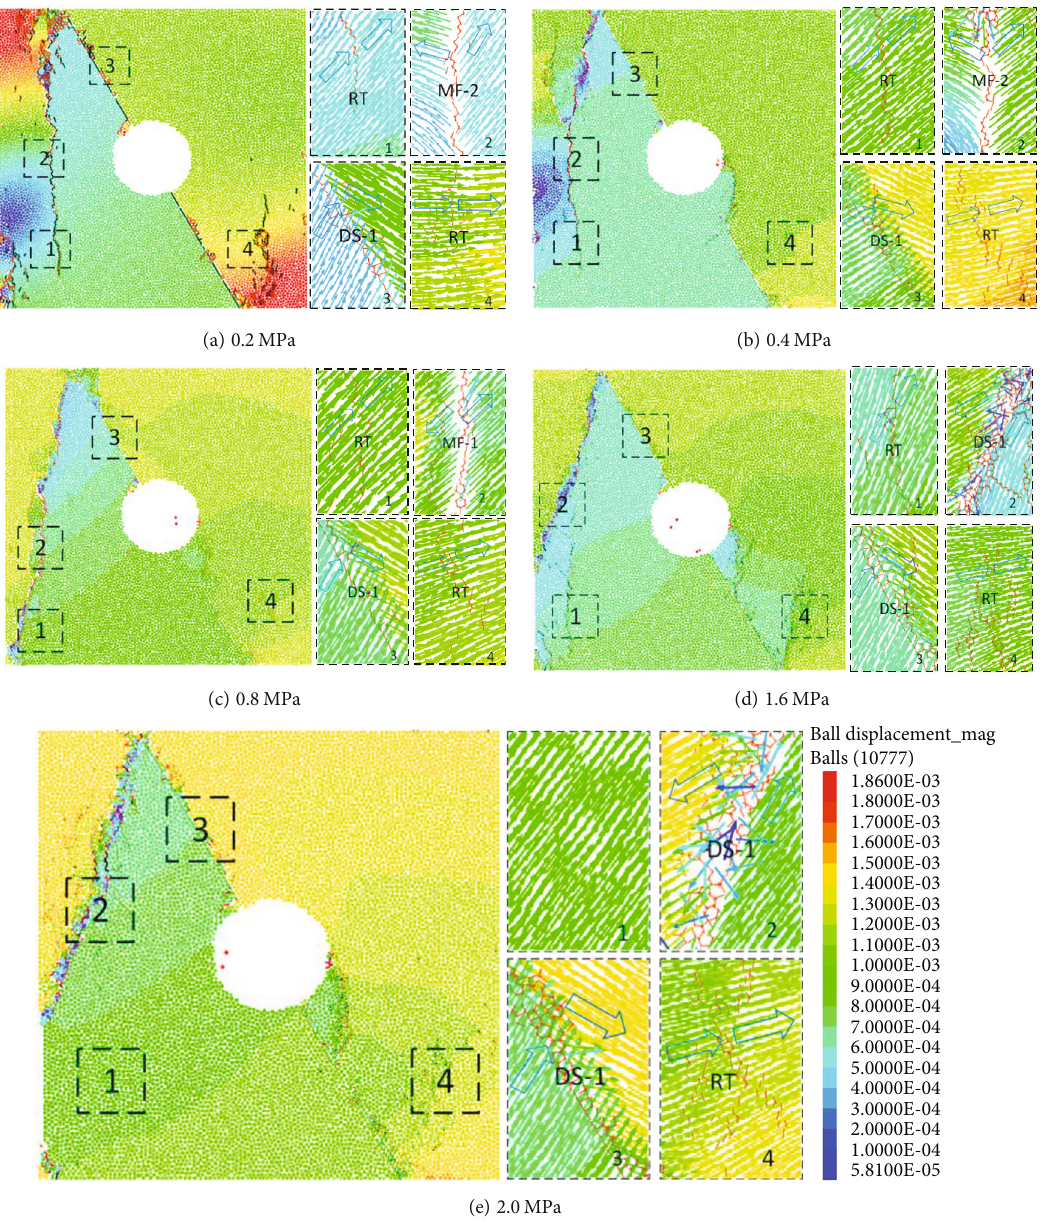
Figure 9: Displacement fi eld vector diagram of 60 ° composite rock specimen under di ff erent con fi ning